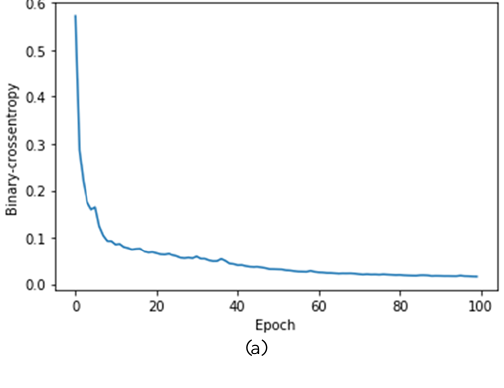
Fig. 4 (a) MSE vs epoch, (b) Training F1 vs epoch using MSE